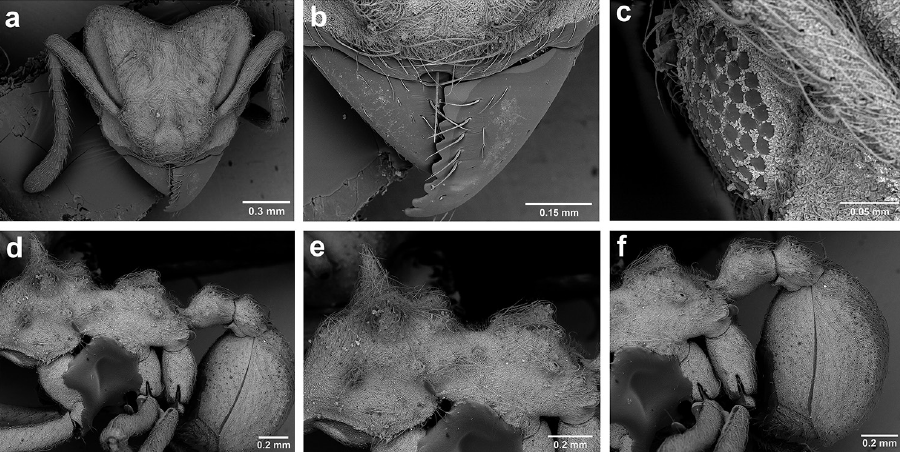
Figure 52. S. radioheadi worker (USNMENT00924061), SEM images. a Head, full-face view b man- dibles c eye d mesosoma and metasoma, lateral view e mesosoma (detail), lateral view f propodeum and metasoma, anterolateral